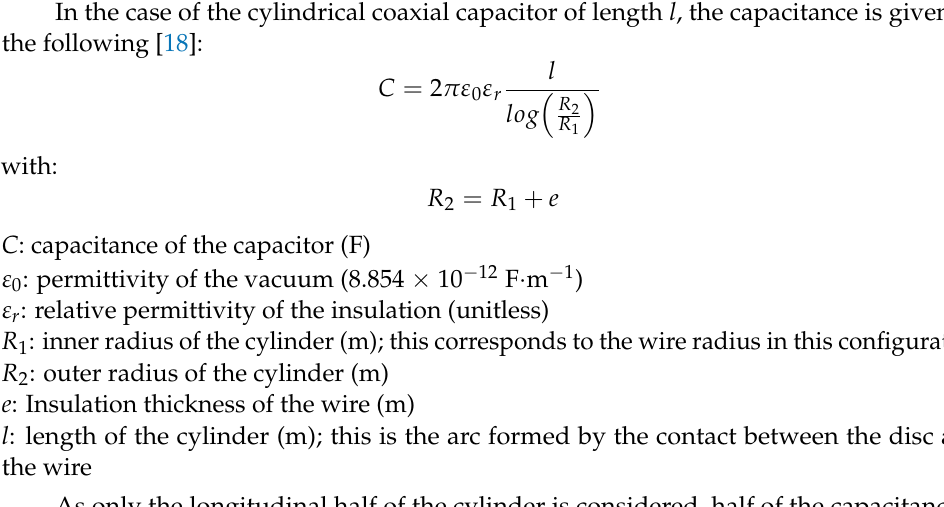
Figure 4. Frontal ( a ) and longitudinal ( b ) sections of the formed capacitor.